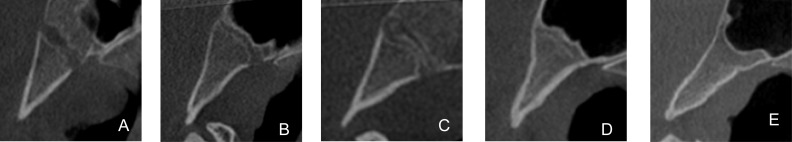
Spheno-occipital synchondrosis fusion stages.A) Stage 1. B) Stage 2. C) Stage 3. D) Stage 4. E) Stage 5.